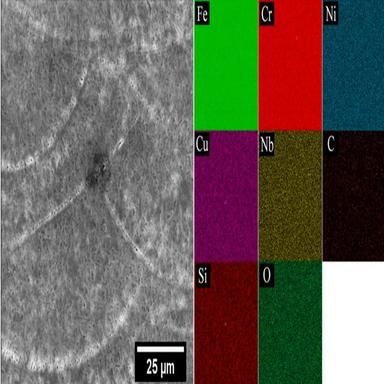
Energy dispersive spectroscopy mappings (right) of the entire SEM image (left) showing no evidence of segregation within the melt pools or in the borders.